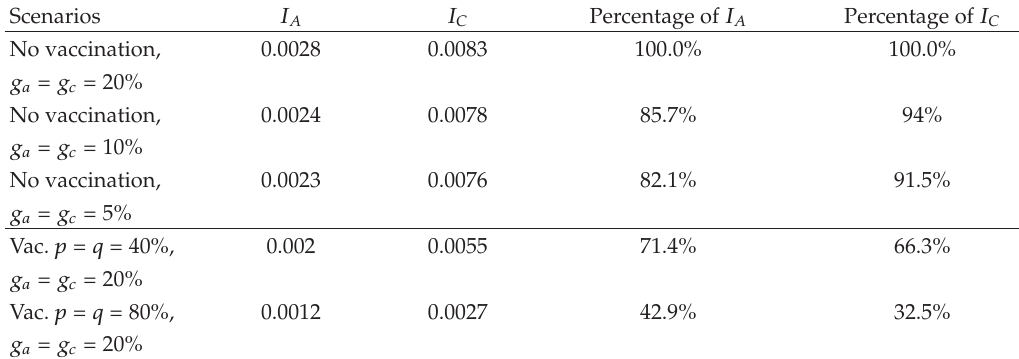
Table 2: Percentages of endemicity. We use the first scenario as a reference scenario for the other four